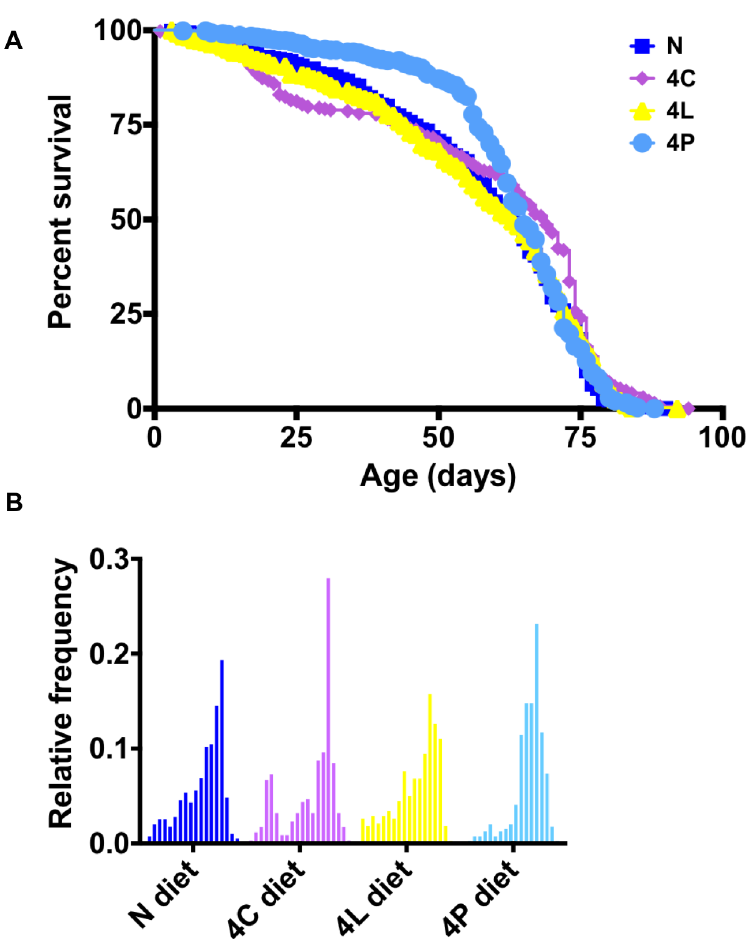
Fig 4. Effects of enriched diets on adult lifespan. Longevity of adult flies fed the indicated diets. n (cid:1) 352 per diet. (A) Survival curves. Log-rank (Mantel-Cox) test indicates that the curves are significantly different (P = 0.0048). Median lifespans (days); N, 63; 4C, 69; 4L, 63; 4P, 65. (B) Histograms of individual